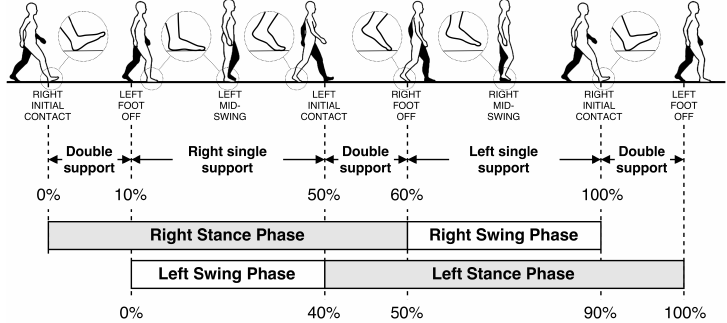
Figure 1. Human gait cycle. Reprinted from “Inertial Sensor-Based Robust Gait Analysis in Non-Hospital Settings for Neurological Disorders” by Tunca, C.; Pehlivan, N.; Ak, N.; Arnrich, B.; Salur, G.; Ersoy, C., 2017, Sensors (Switzerland), 17, 1–29. c (cid:13) 2017 by the authors. Reprinted with